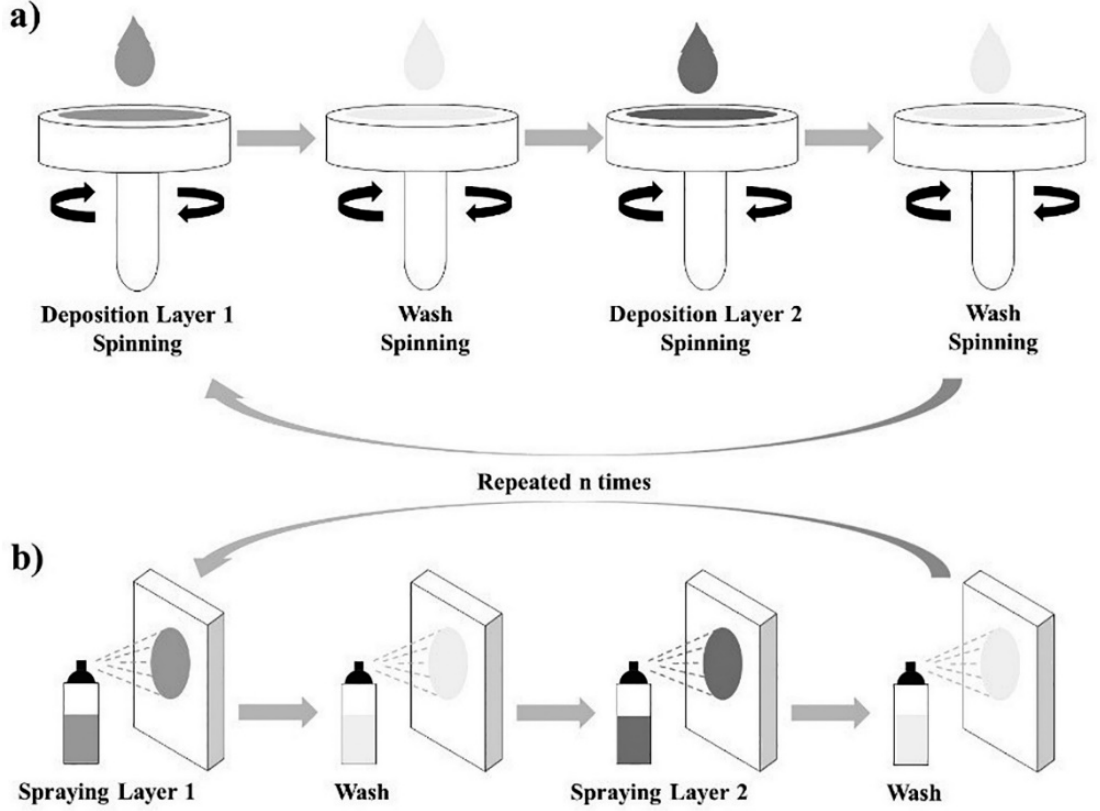
Figure 3. Schematic representations of the assembly of LbL nanomaterials by spin-coating ( a ) and spray-assisted ( b ) deposition methodologies. Reprinted with permission from Ref. [41]. Copyright